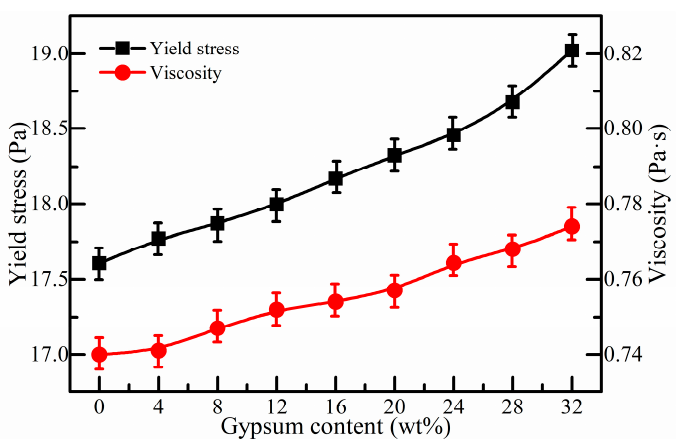
Figure 12. Yield stress and viscosity for fresh SSB-CPB with different DG dosages.